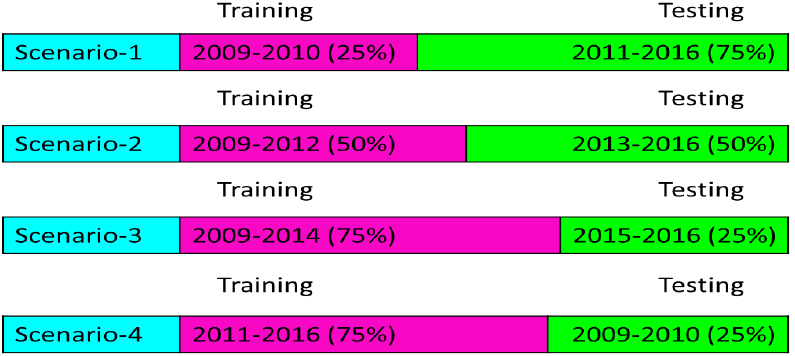
Figure 5. Percentage of training and testing datasets in the four different scenarios.